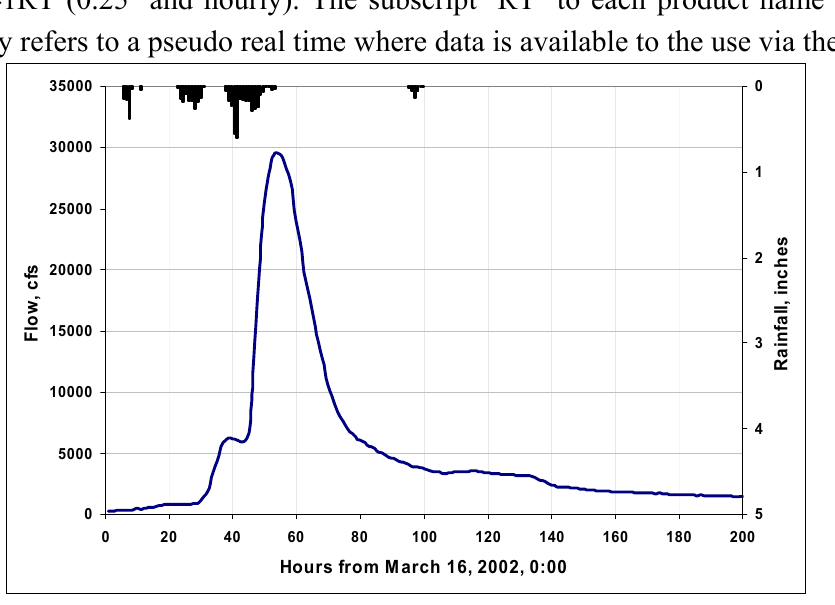
Figure 3. Rainfall and runoff for the March 2002 storm